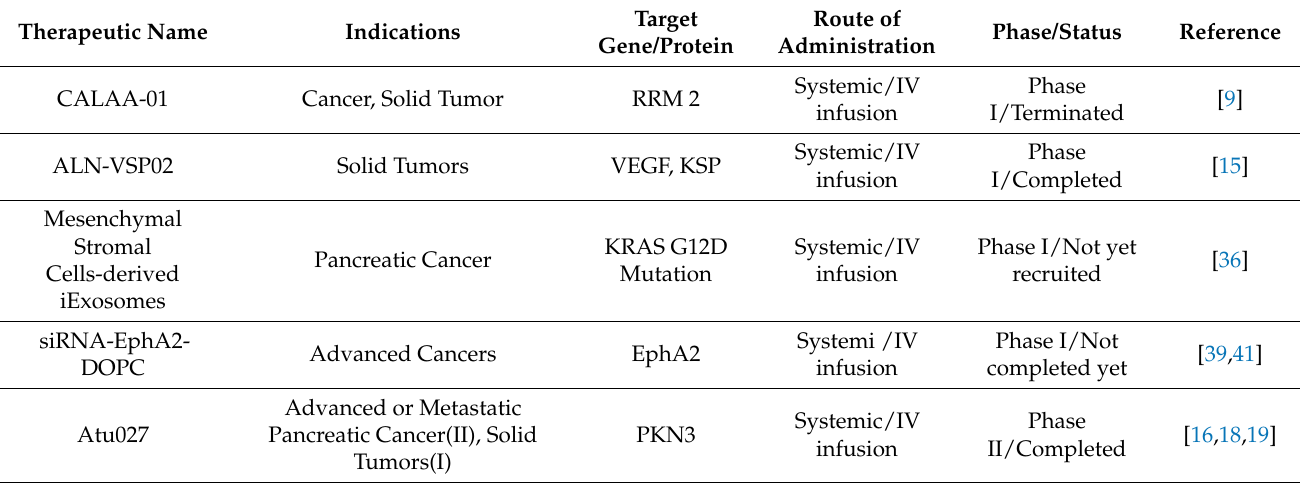
Table 1. Anticancer siRNA mediated nanoparticles in clinical